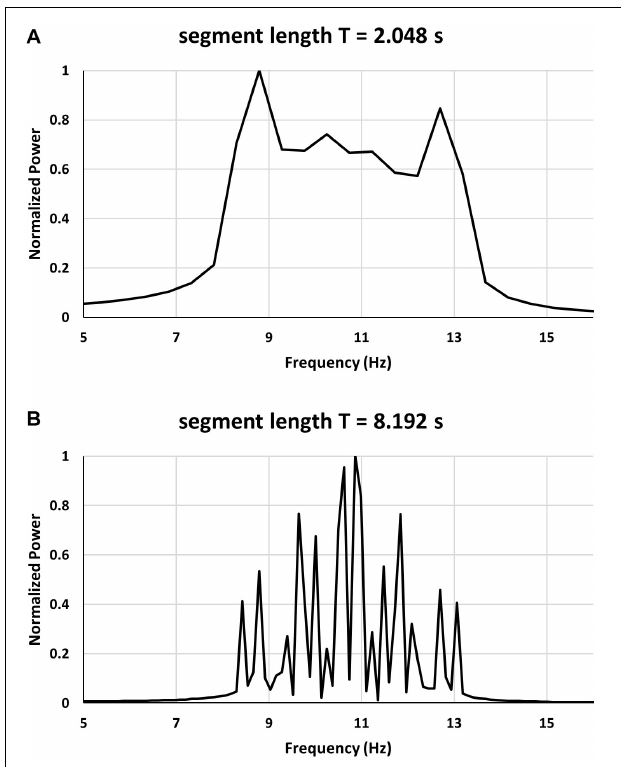
FIGURE 3 | Comparison of power spectra for a sum of 22 sine waves with frequencies equally spaced in 8–13 Hz range: (A) no window, (B) triangular window applied to signal.